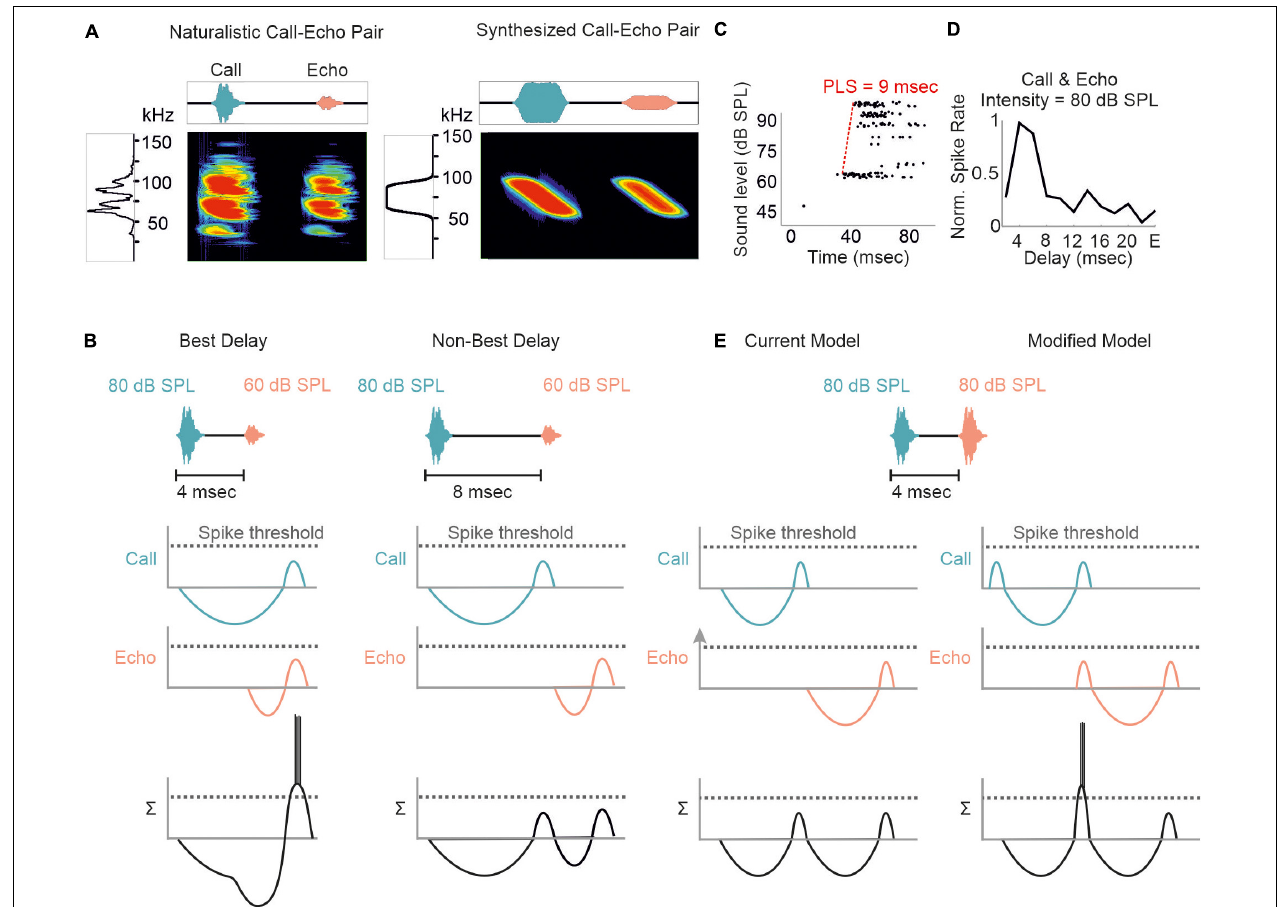
FIGURE 4 | Proposed models of delay tuning in FM-bats. (A) Oscillogram, spectrogram, and power spectrum of a naturalistic call-echo pair of C. perspicillata ( left ) and a synthesized call-echo pair ( right ). For simplicity the power spectrum represents the call only. (B) Proposed model of delay tuning in FM-bats. Post-synaptic responses of a delay-tuned neuron are schematically shown in response to the neuron’s best delay (4 ms, left ) and a non-best delay (8 ms, right ). Post-synaptic inputs from call and echo are depicted in green and orange, respectively. The summed response ( (cid:54) ) of the delay-tuned neuron is shown in black. Note that the neuron spikes only when the inhibitory rebounds from call and echo coincide. (C) Rate-level function of a cortical delay-tuned neuron showing a paradoxical latency shift (PLS) of about 9 ms. Each dot of the raster plot represents a spike (D) Delay-tuning curve from a cortical neuron of C. perspicillata that is sensitive to equally intense call and echo (80 dB SPL). (E) The current model of delay-tuning in FM-bats cannot explain delay tuning to equally intense call and echo ( left ). By adding an initial excitatory component, delay-tuning to equally intense call and echo can be explained ( right ). In the modified model, the post-inhibitory rebound from the call response coincides with the initial excitatory response to the echo, thus passing the spike threshold. Data shown in (C) are adapted from Hechavarría and Kössl